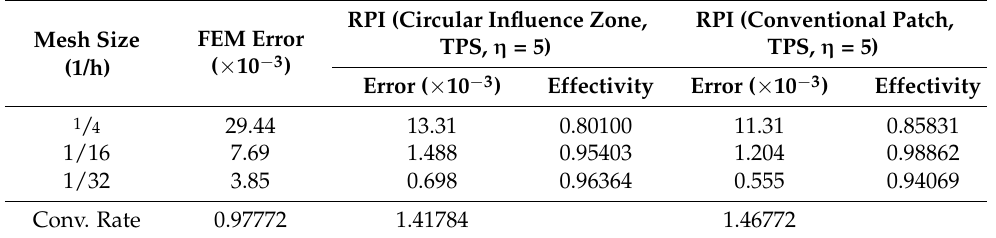
Table 6. Error properties results for RPI (TPS)-based recovery techniques in incompressible-elastic plate analysis considering TPS RBF shape parameter and conventional patches (four-node quadrilat- eral regular